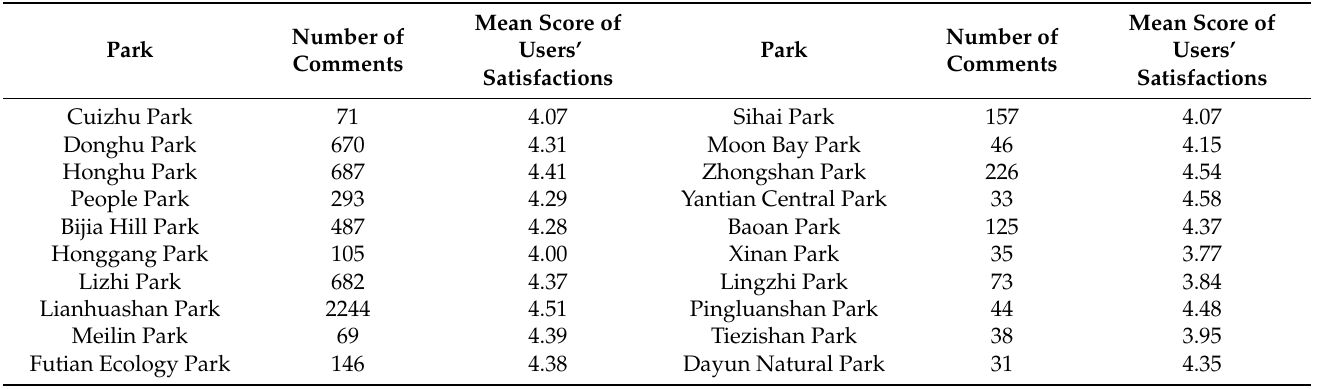
Table 2. The number of comments and the mean score of users’ satisfactions of each park with the number of comments exceeding